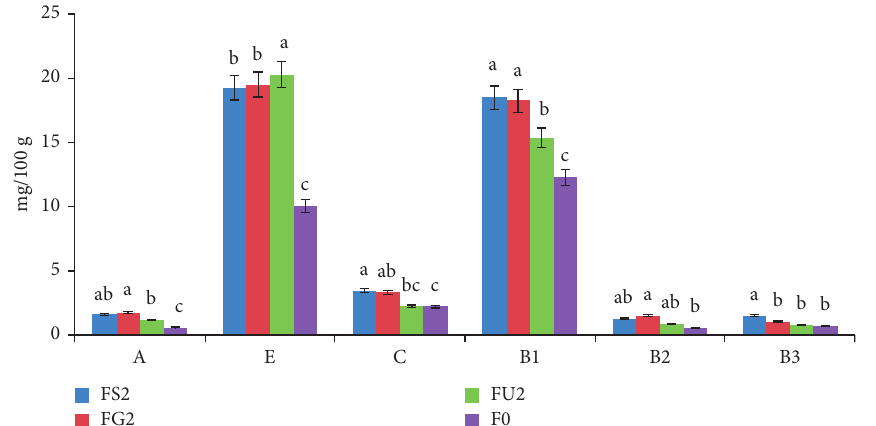
Figure 1: Vitamin content of sour fruits with 3% algae powder. Different letters indicate significant differences ( p < 0 . 05 ) .